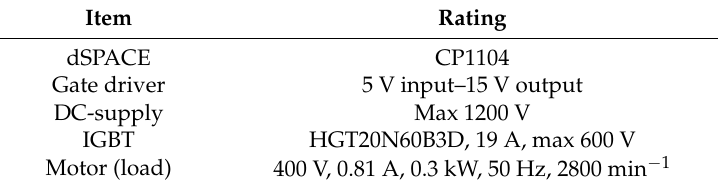
Table 4. Rating of the setup experiment components and equipment.